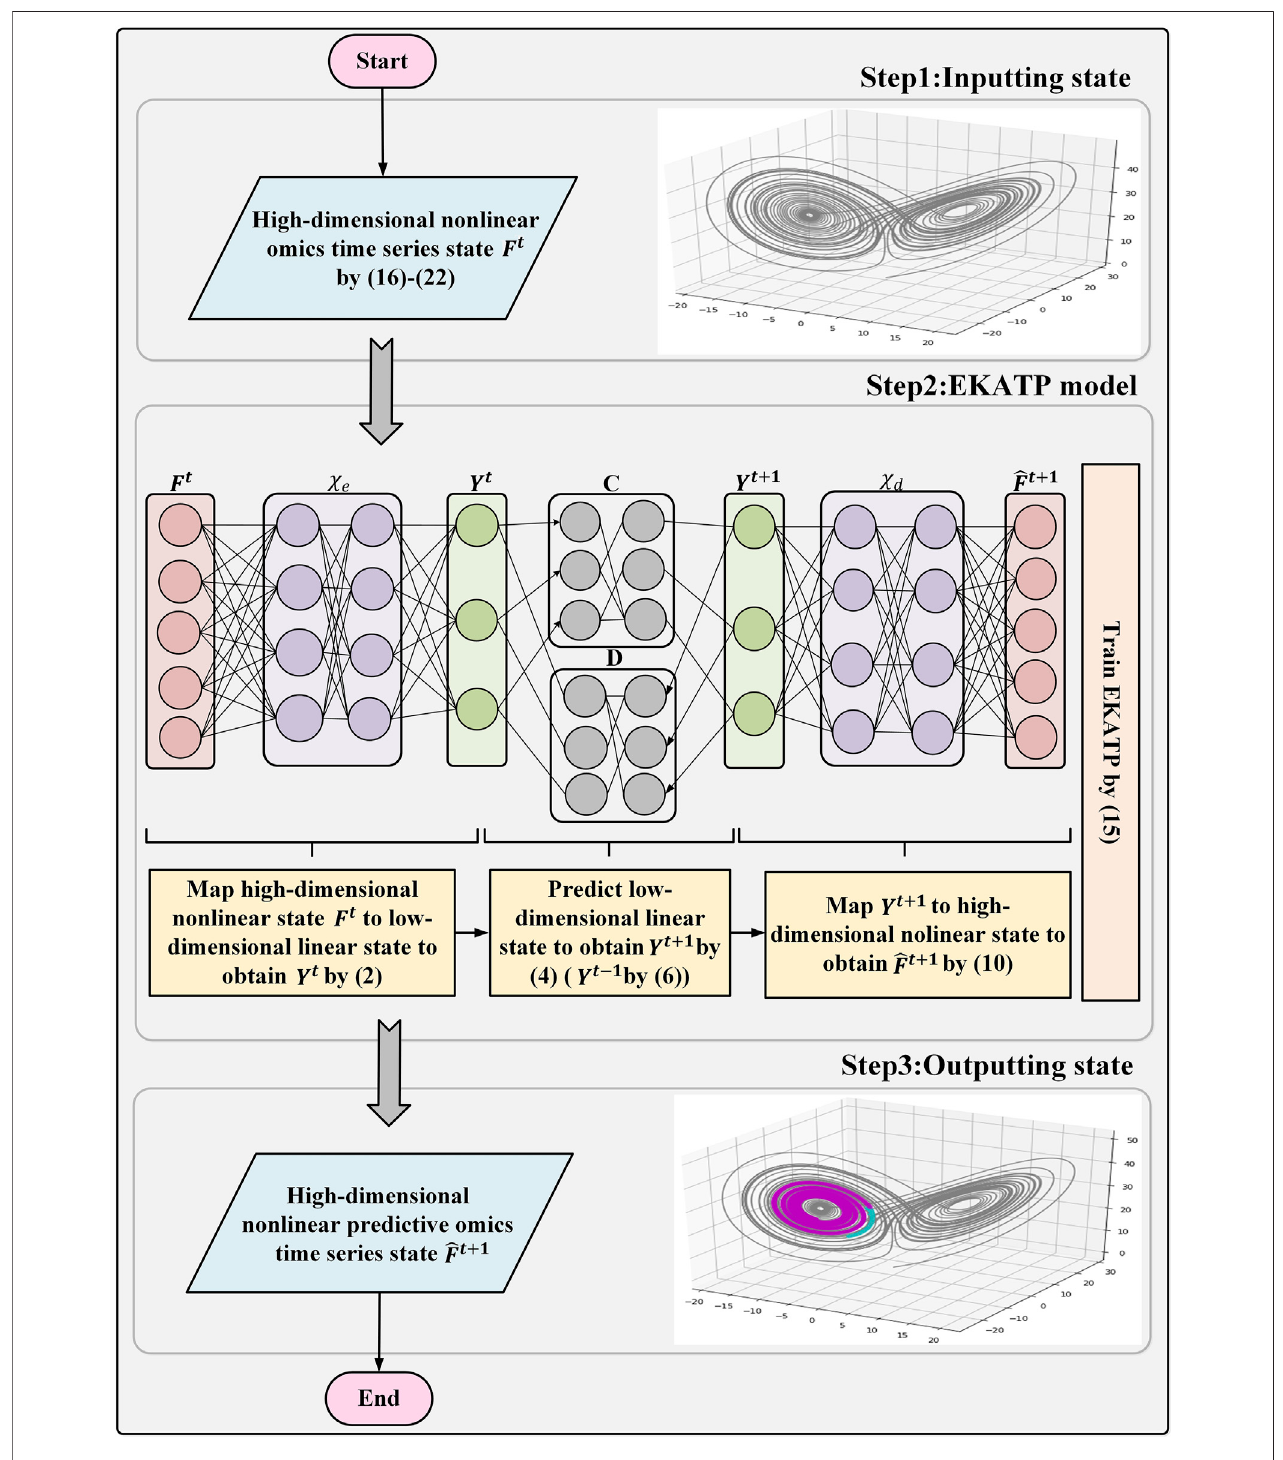
FIGURE 1 | EKATP work fl ow.